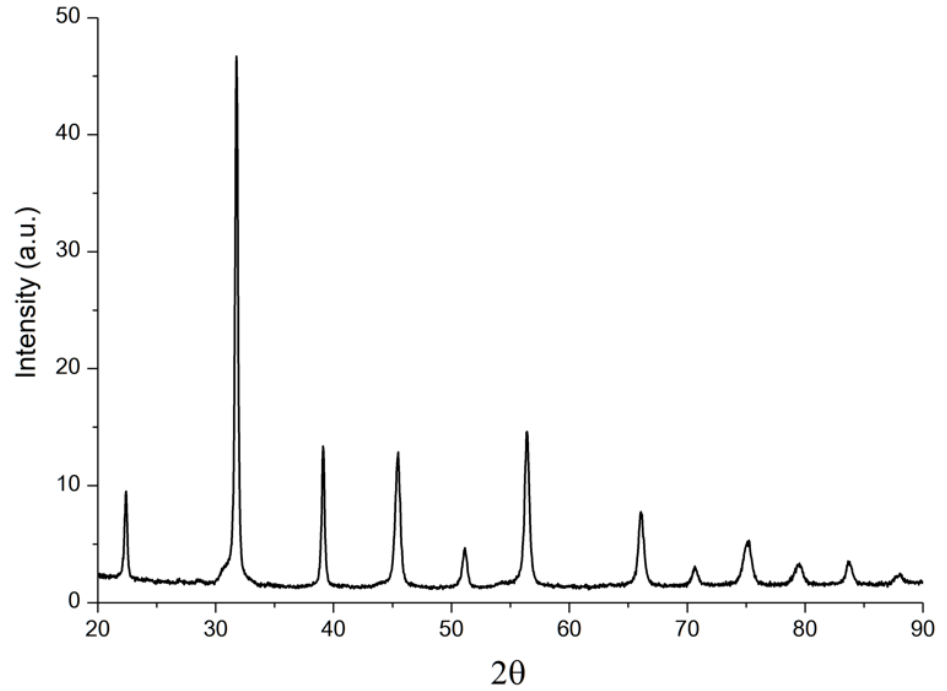
Figure 2. XRD results of BCZT powder after solid-state synthesis.